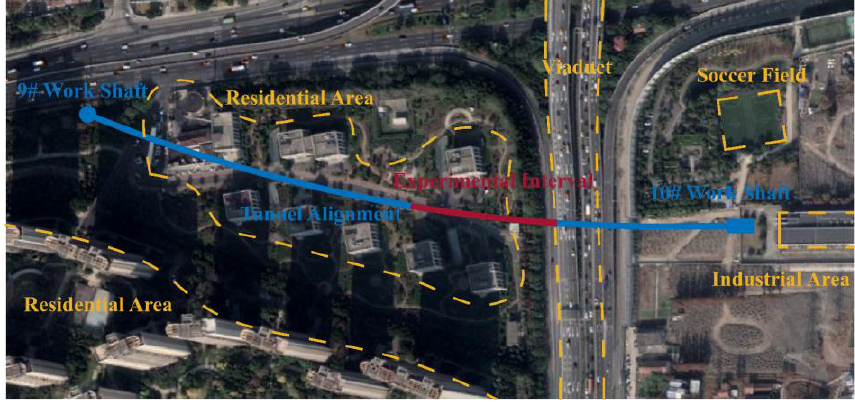
Figure 1. Plan view of a power transmission tunnel interval between 9#~10# work shaft.